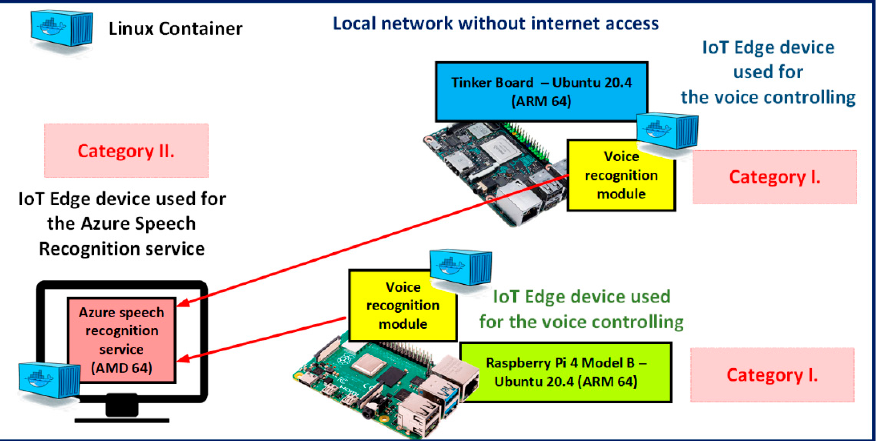
Figure 8. Categories for edge devices.